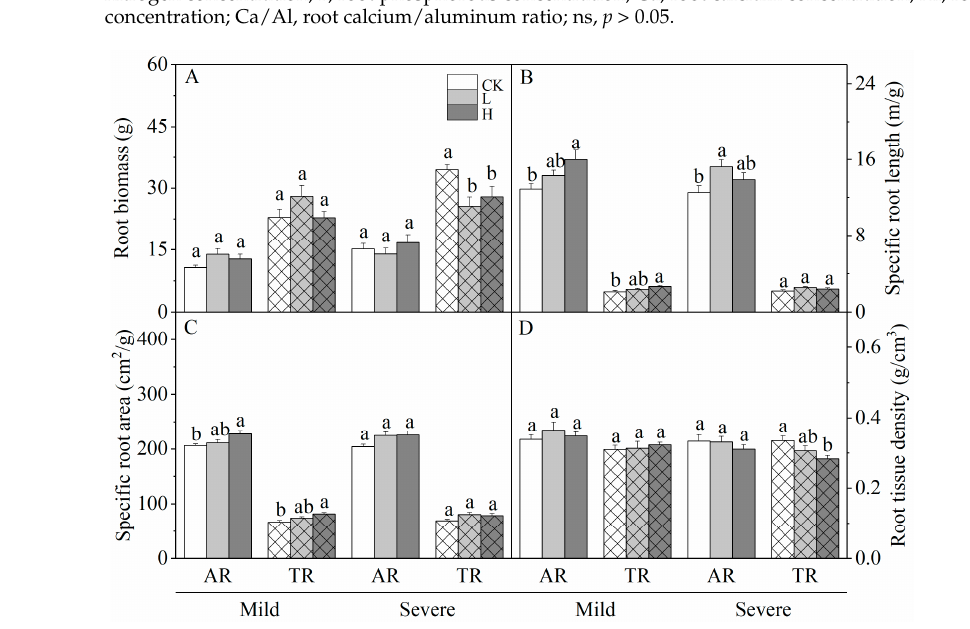
Figure 1. Fine-root biomass and morphologies of two functional roots among three treatments (CK, control; L, low CaCO 3 addition; H, high CaCO 3 addition) and two acidification degree soil samples (Mild, mildly acidified soil; Severe, severely acidified soil). Data shown are mean + SE (N = 8). Bars without grid represent absorptive fine roots (AR), and bars with grid represent transportation fine roots (TR). Different lower-case letters indicate significant differences at p < 0.05 level among different liming treatments in the same functional root (AR or TR) within the same soil type (Mild or Severe), as evaluated by one-way ANOVA; ( A ) root biomass; ( B ) SRL or specific root length; ( C ) SRA o specific root area; ( D ) RTD or root tissue density. Table 2. Three-way ANOVA analysis for fine-root morphologies and nutrient concentrations among different soil acidification degrees (Acid), liming levels (CaCO 3 ), and fine root functional group (Root).